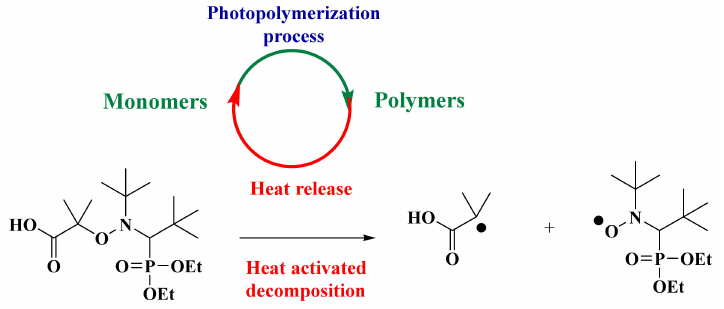
Figure 9. Photopolymerization mechanism.